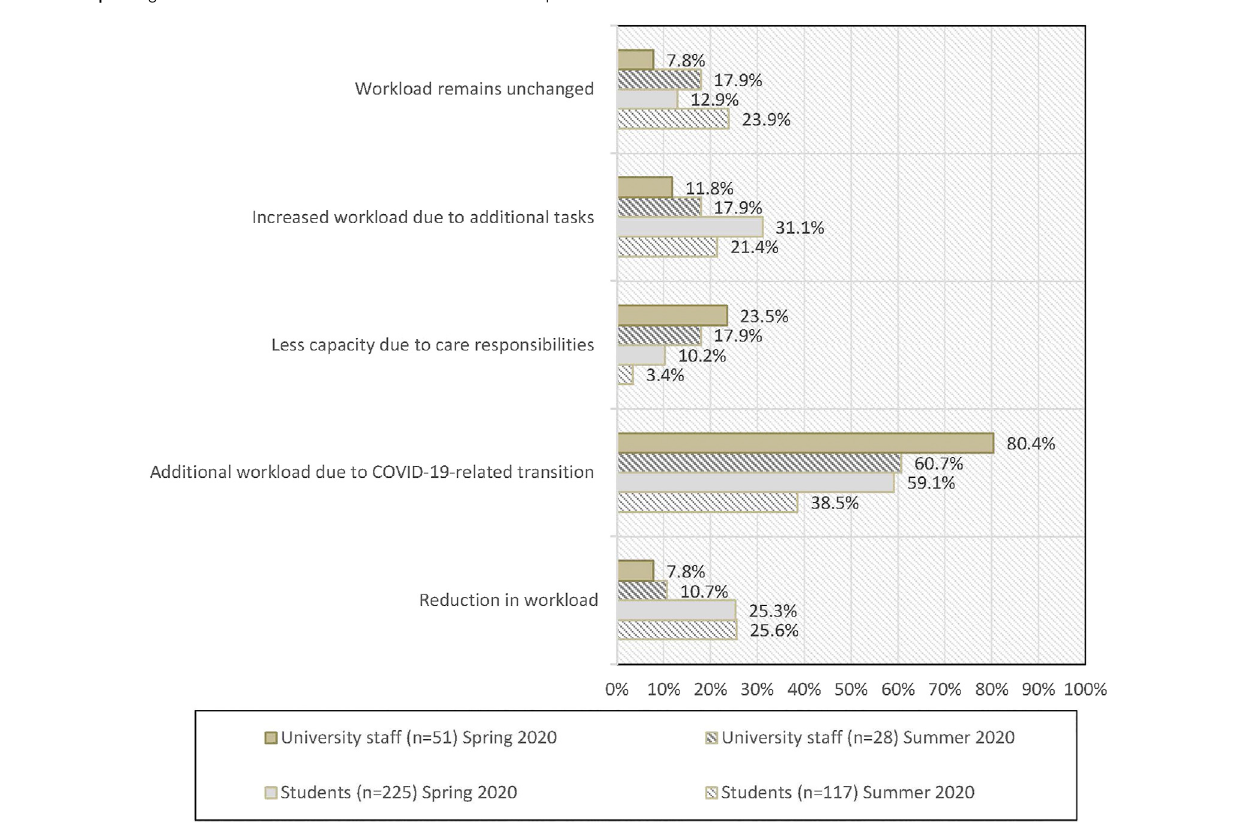
FIGURE 1 | Change in staff and students` workload due to COVID-19